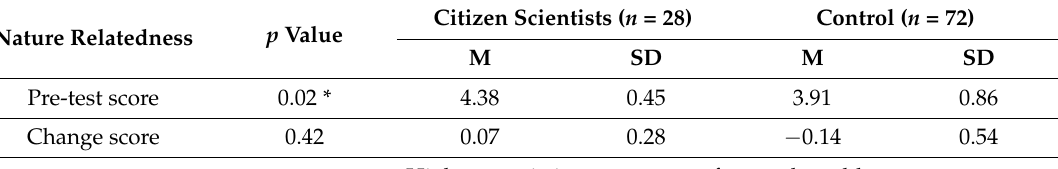
Table 7. Joint display of nature relatedness mean (M) pre-test and change scores, standard deviations (SD), Mann–Whitney U p -scores (* significant at p < 0.05) and qualitative findings.